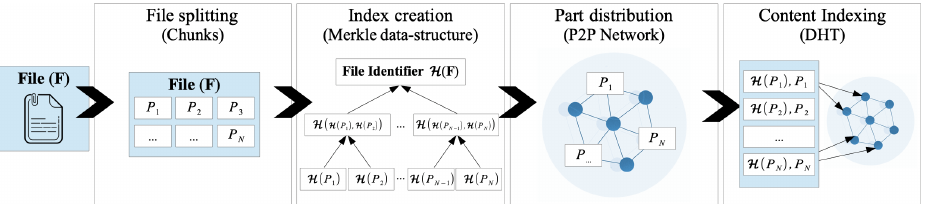
Figure 2. Block scheme of the decentralized storage protocol for splitting a file F into N pieces P n stored along with the hash H ( P n ) in the